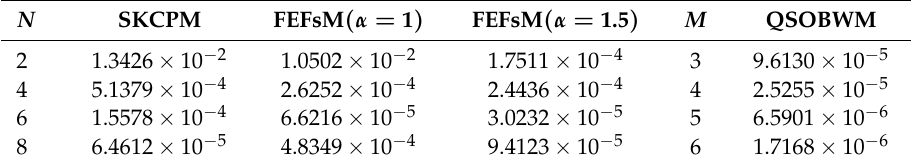
Table 2. L 2 errors of QSOBWM, second-kind Chebyshev polynomials method (SKCPM) (in [8]), and FEFM (in [9]) for Example